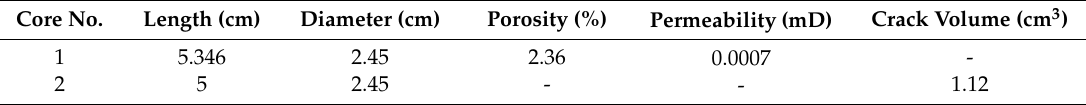
Table 2. Characteristics of